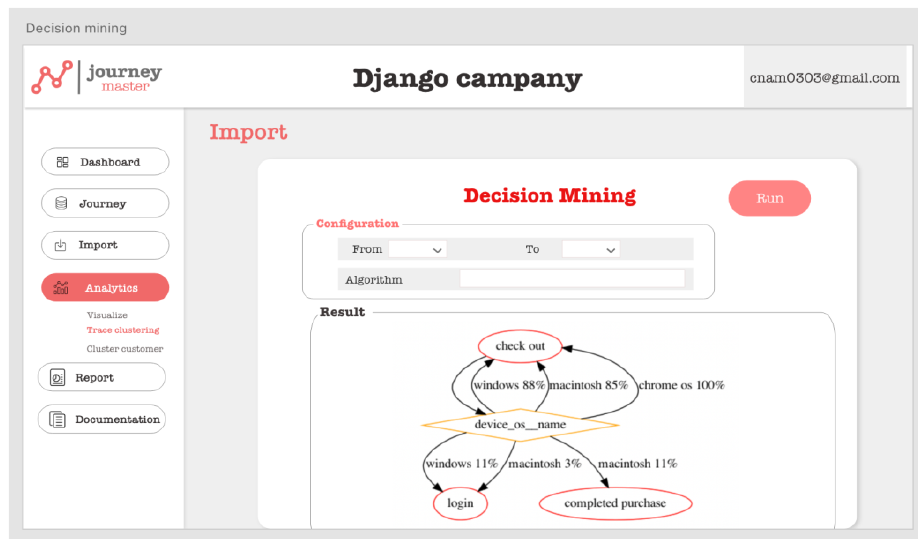
Fig. 6. Customer decision